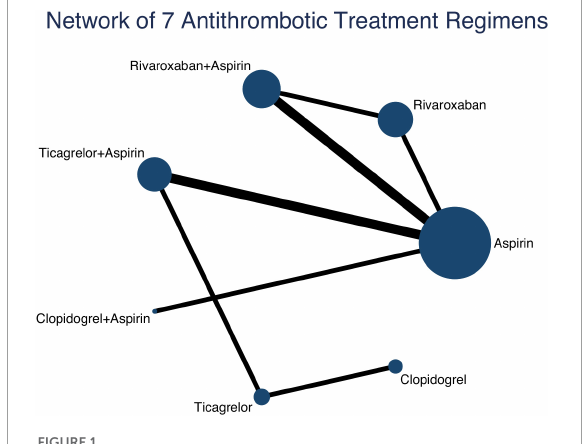
FIGURE1 Network of 7 antithrombotic treatment regimens. Lines connect the interventions that have been studied in head-to-head (direct) comparisons in the eligible RCTs. The width of the lines represents the cumulative number of RCTs for each pairwise comparison and the size of every node is proportional to the number of randomized participants (sample size). RCTs, randomized controlled